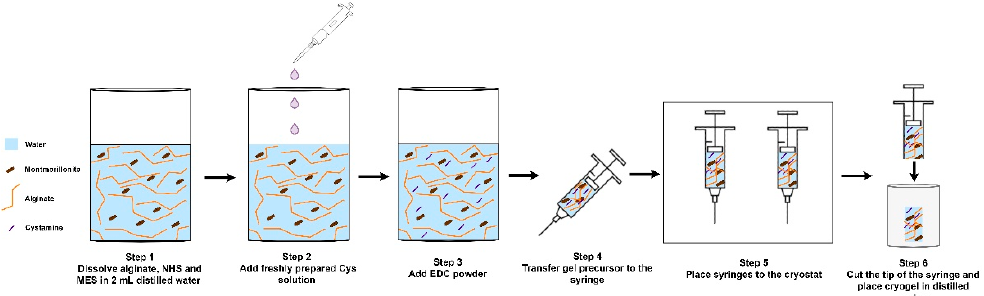
Figure 10. Schematic representation of the preparation of gel precursor of alginate/MMT cryogels and transfer of gel precursor solution to the cryostat.